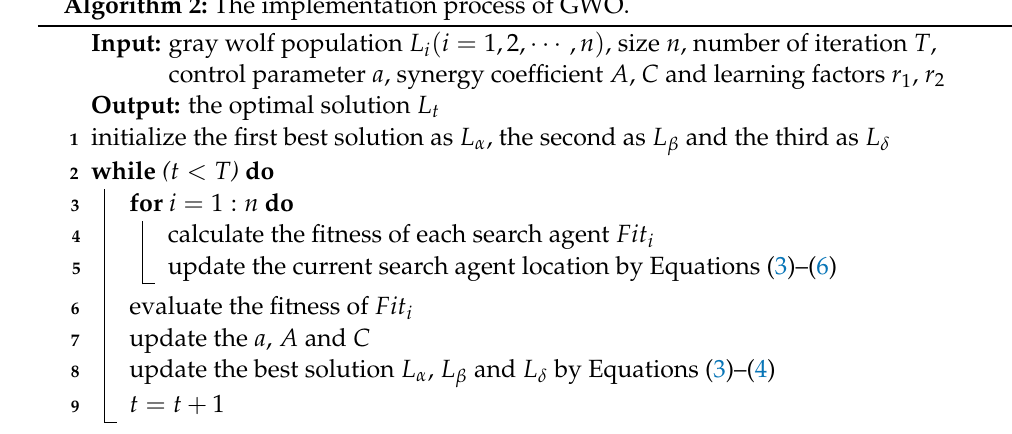
Algorithm 2: The implementation process of